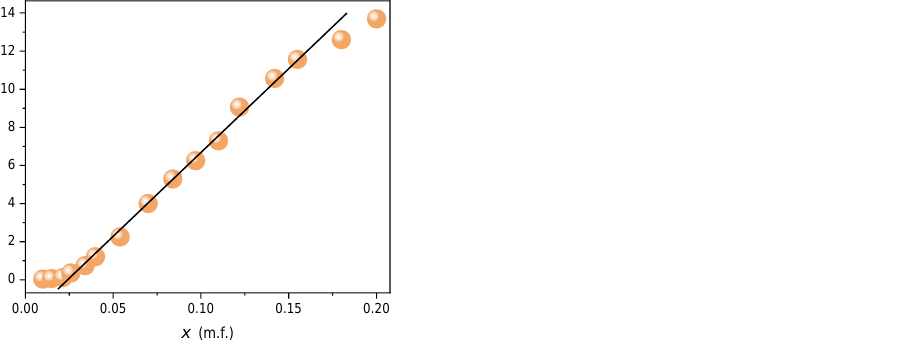
Figure 12. Results of the analysis of TP1 isotropic-nematic coexistence domain for low concentrations of isooctane ( TP1 domain) validating the portrayal via Equation (10).